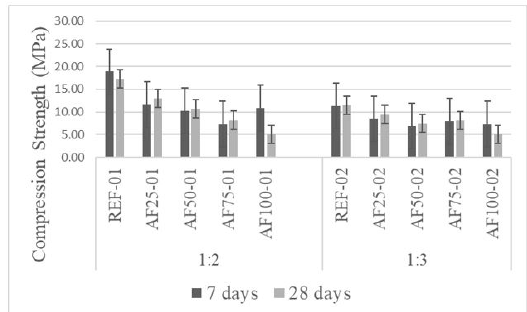
Figure 5. Compression Strength test results for 7 and 28